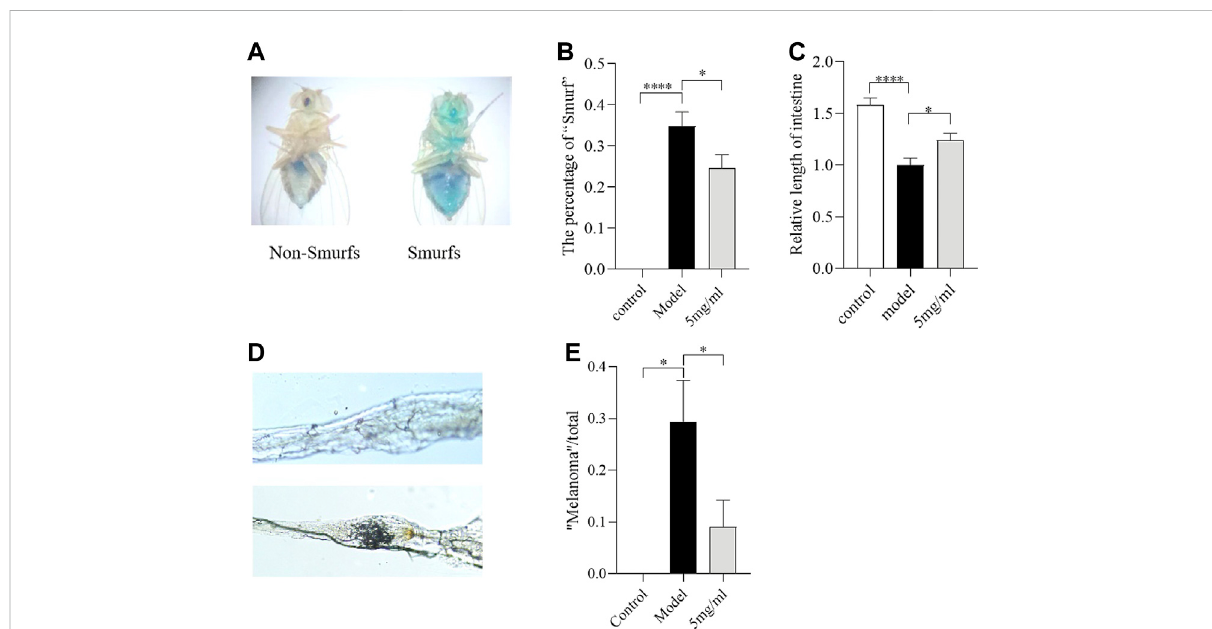
FIGURE 4 The FPE ameliorates the morphological change of the intestine against SDS-induced injury. (A) Schematic diagram of fl ies that underwent the Smurf assay. The percentage of “ Smurf ” ( n = 170 – 190) (B) and relative length of intestine ( n = 12) (C) in control fl ies or FPE treated fl ies that fed with 0.6% SDS. (D) Nomarski images of the fl y gut. Up panel, “ Non-malanotic mass ” ; down panel, “ malanotic mass ” . (E) The percentage of “ malanotic mass ” fl ies ( n = 33 – 34). * p < 0.05, **** p < 0.001 vs. the model